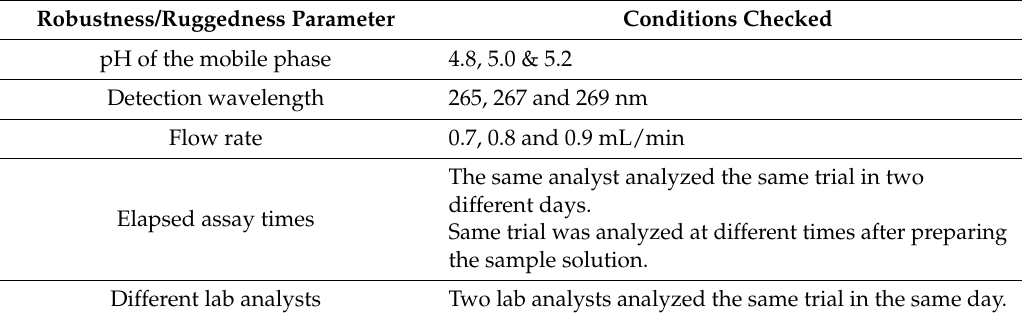
Table 2. The applied ruggedness and robustness conditions for the method of determination of amoxicillin and